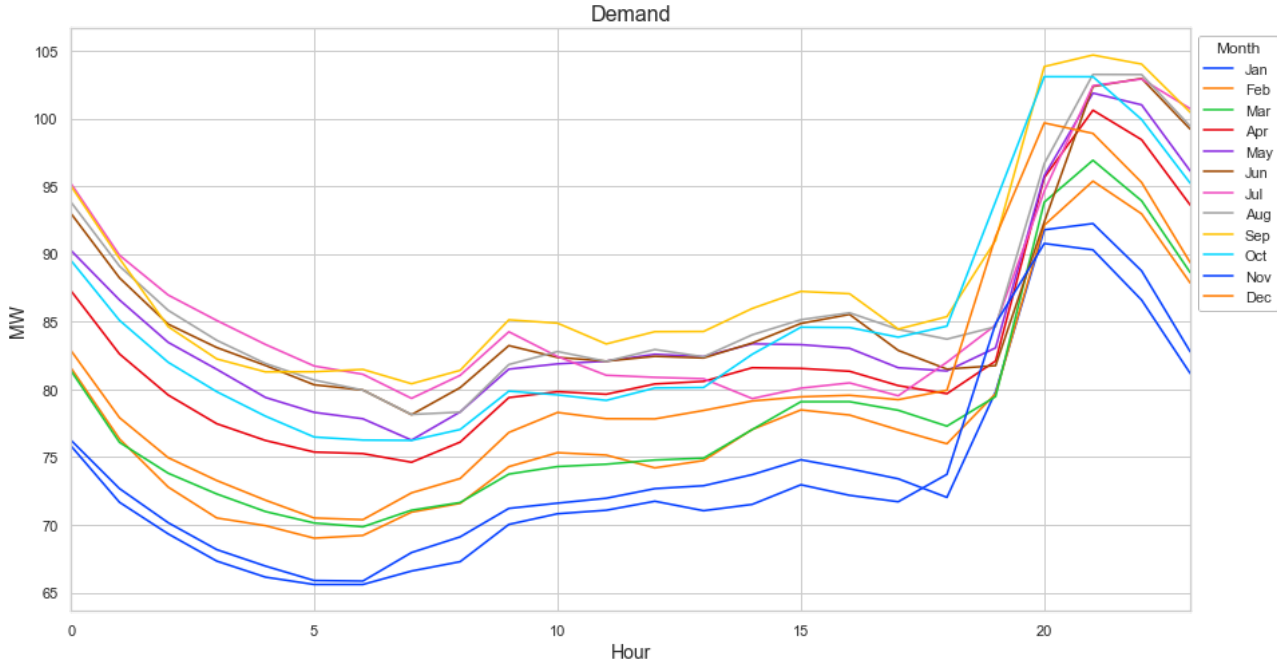
Figure 5. Average monthly demand in the southern zone.